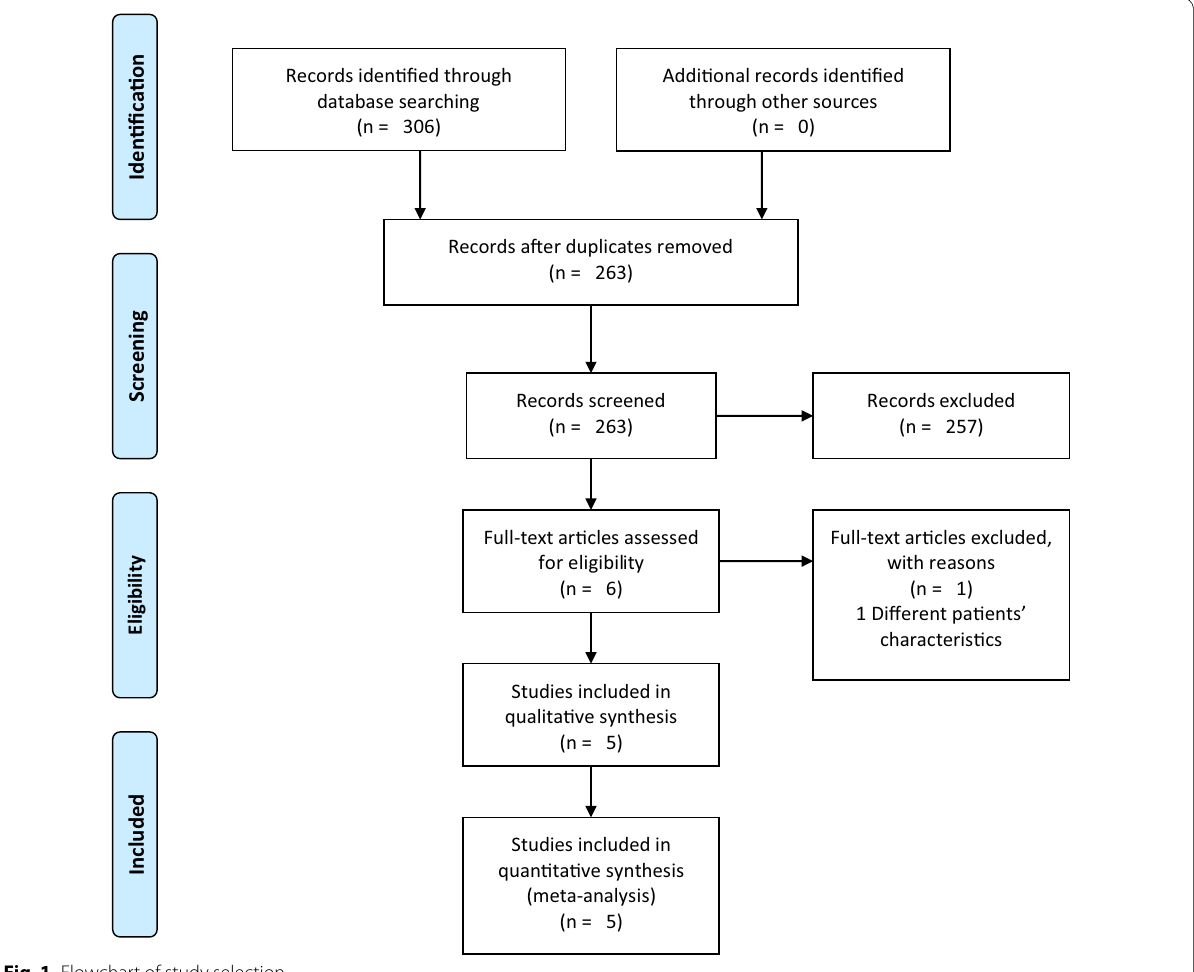
Fig. 1 Flowchart of study